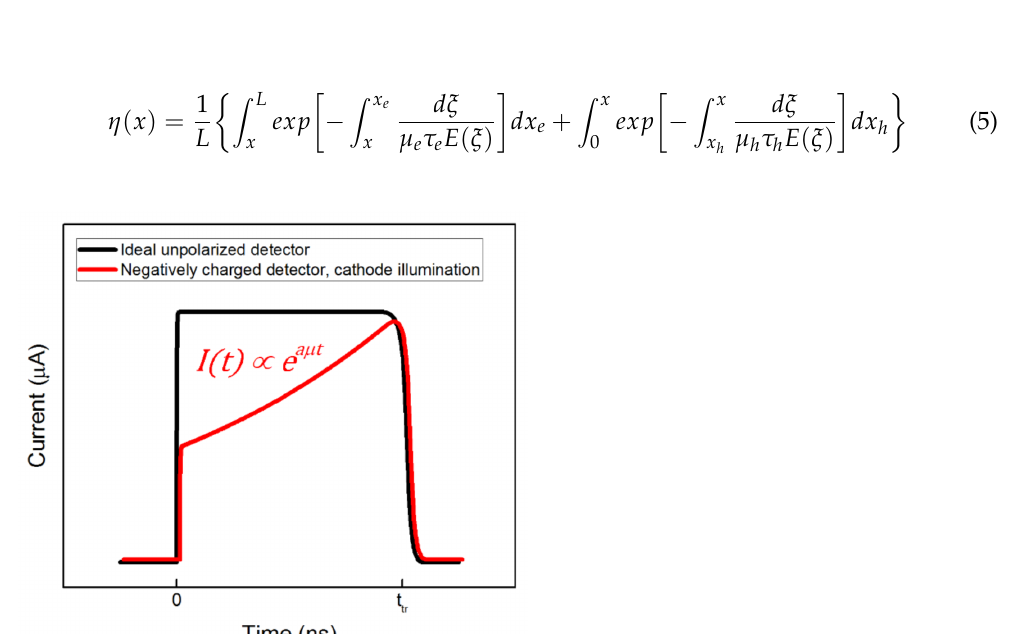
Figure 1. Example of electron current waveforms (CWFs) in an ideal nonpolarized (black) and negatively charged polarized detector (red). The descending part of the CWF is smeared by the diffusion. The t tr is set to the point of inflexion. Typically, the current maximum reaches several µ A and t tr is in the range of tens to hundreds of